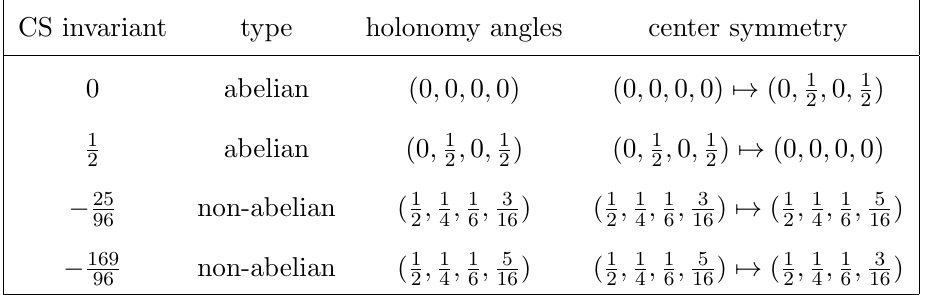
Holonomy angles and Chern-Simons invariants of SU(2) (cid:13)at connections on M ( 1; 1 ; 1 ; 1 ), and the center symmetry among 2 3 8 (cid:0)